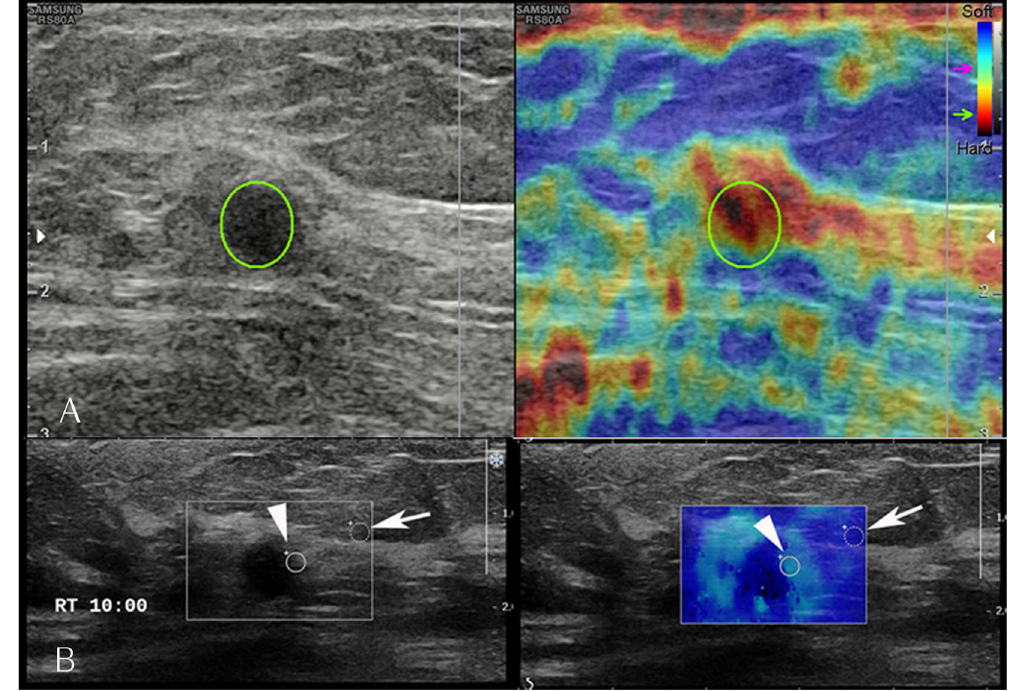
Figure 4. Representative images showing the region of interest used to obtain the strain ratio and elasticity ratio. ( A ) An oval region of interest (ROI) was set to include the mass (circle), in which the ultrasound machine automatically calculated and visualized the strain ratio as the mean strain within the ROI drawn along the border of the mass divided by the mean strain of the fat located at and above the level of the ROI set for mass strain measurement; the strain measured within the ROI set for mass measurement was excluded. ( B ) The elasticity ratio was calculated as the target round, solid ROI, located within the stiffest part of the lesion (arrow head) divided by another reference ROI in the adjacent subcutaneous fat